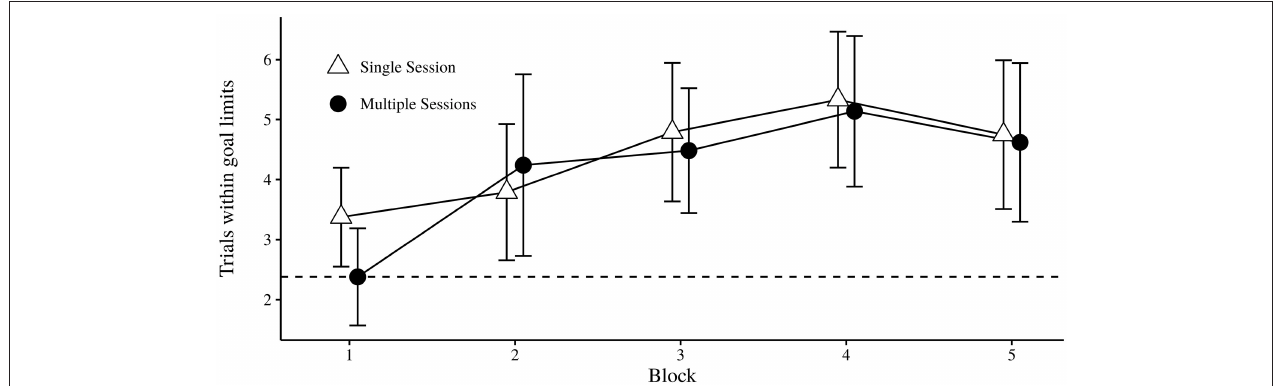
FIGURE 3 | Mean number of trials on target for each condition over successive blocks. Error bars indicate 95% CI. The dotted horizontal line represents chance level.